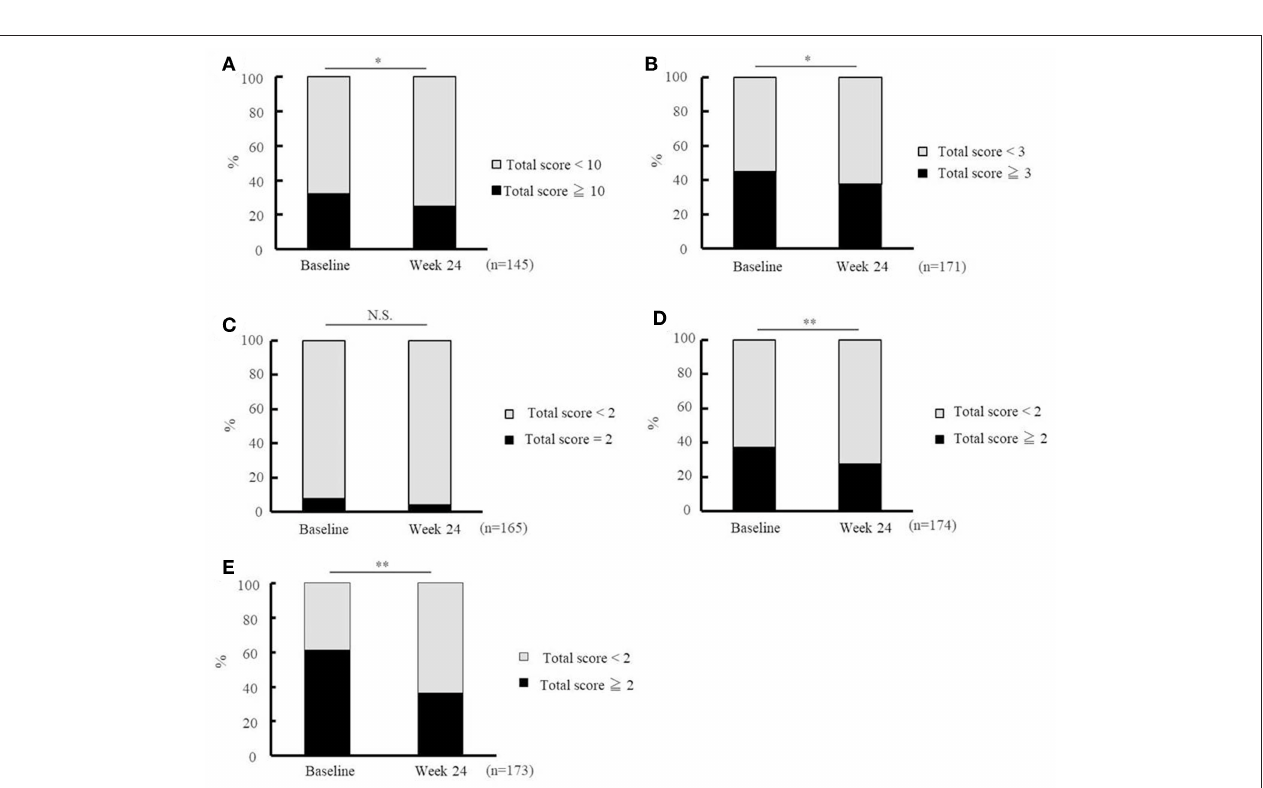
FIGURE 4 | Effectiveness of Ninjin’yoeito as determined by Basic Checklist assessment. Changes in the risk ratio of care dependency accessed using the Basic Checklist after Ninjin’yoeito (NYT) administration: questions 1–20 for activities of daily living assessment (A) , questions 6–10 for motor function assessment (B) , questions 11 and 12 for nutritional assessment (C) , questions 13–15 for oral function assessment (D) , and questions 21–25 for depression assessment (E) . Data are presented as the mean ± standard deviation, * p < 0.05 and ** p < 0.01 compared with the baseline as determined using the McNemar test. According to the criteria, a person with a total score of ≥ 10 for questions 1–20 (activities of daily living), ≥ 3 for questions 6–10 (motor function), = 2 for questions 11 and 12 (nutrition), ≥ 2 for questions 13–15 (oral function), or ≥ 2 for questions 21–25 (depression) was considered to be in need of care dependency; Basic Checklist, the 25-item Basic Checklist; (n), number of